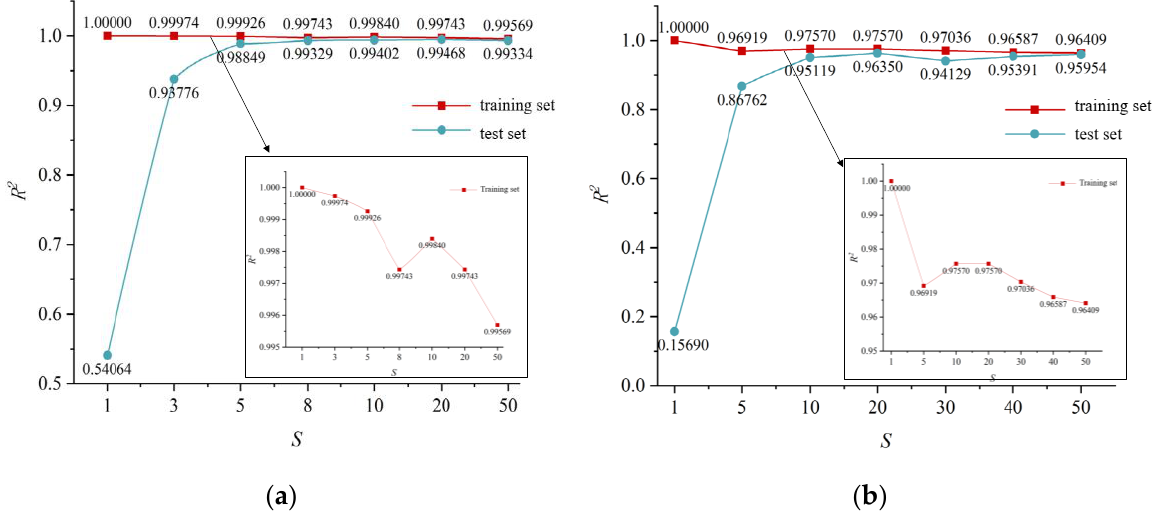
Figure 13. Influences of spread ( S ) on R 2 of training set and test set. ( a ) T V u / 20 V u ratio; ( b ) T V e / 20 V e ratio.